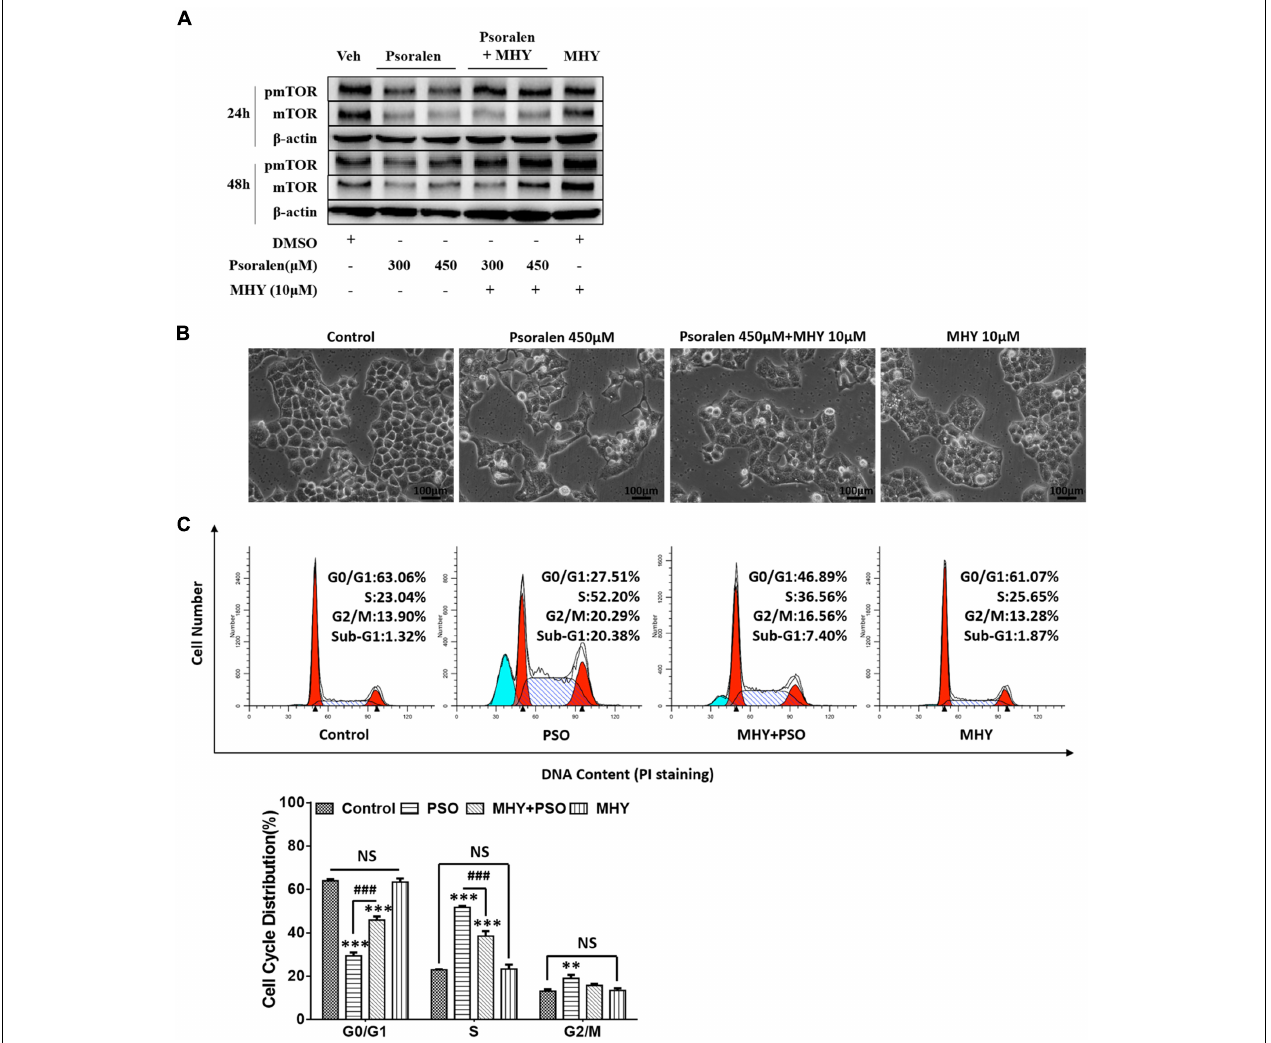
FIGURE 8 | MHY alleviated the inhibition of mTOR and S phase-arrest induced by psoralen in L02 cells. L02 cells were pretreated with 10 µ M MHY, an mTOR activator, for 12 h and then co-treated with 300 µ M and/or 450 µ M psoralen for 24 h and/or 48 h. (A) Western blot analysis of mTOR protein levels. (B) The representative images of L02 cell morphology. (C) Cell cycle analysis using PI staining. Upper panel: representative results of flow cytometry analysis; lower panel: quantitative statistics of cell cycle distribution. PSO, psoralen. All experiments were performed three times independently and the quantitative data are shown as the means ± SDs. ∗∗ p < 0.01, ∗∗∗ p < 0.001 versus control group. ### p < 0.001, MHY + psoralen group versus psoralen